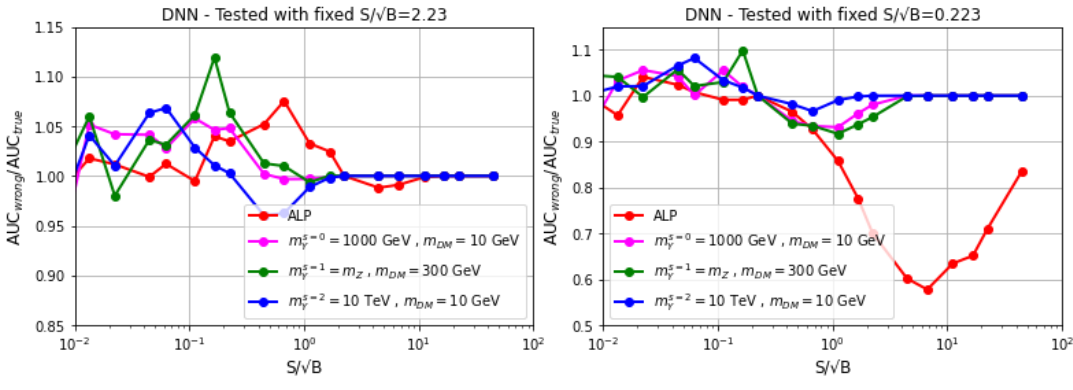
(cid:112) B = 2.23 (left Figure 11: Ratio of the AUCs for histograms constructed with S / (cid:112) (cid:112) B = 0.223 (right panel), applied on DNNs trained with S / B as panel), and S / pointed out on the horizontal axis. AUC corresponds to the result of DNNs with wrong non-matching test and train data sets, and AUC with matching true